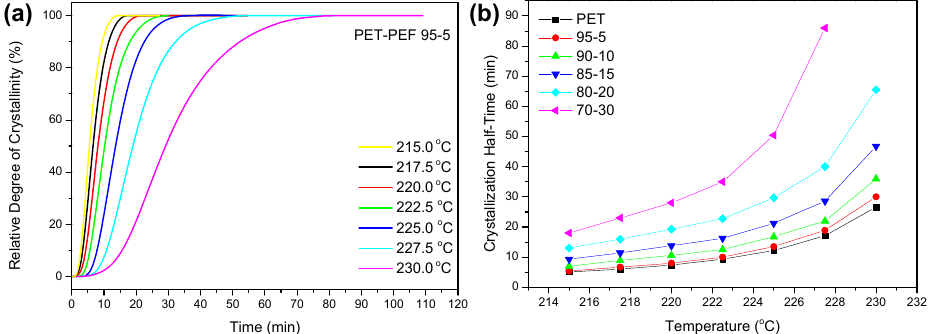
Figure 7. ( a ) Evolution of the relative degree of crystallinity with time for the PET-PEF 95-5 blend at various temperatures and ( b ) dependence of the isothermal crystallization half-time on the temperature for blends with high PET content.